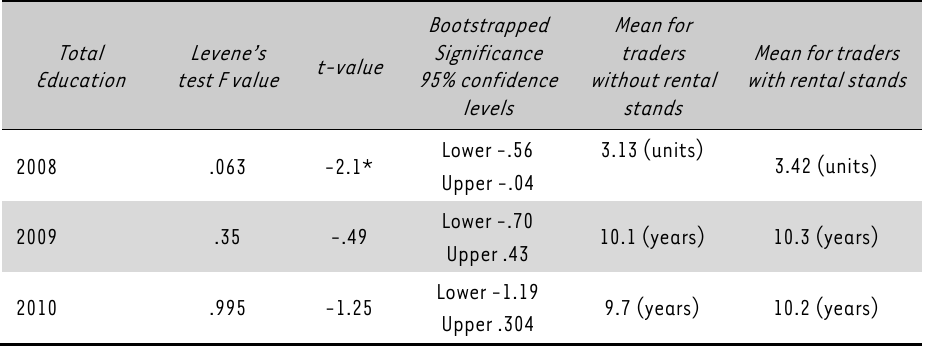
TABLE 5: Results of the t-tests for differences in Total Education Total